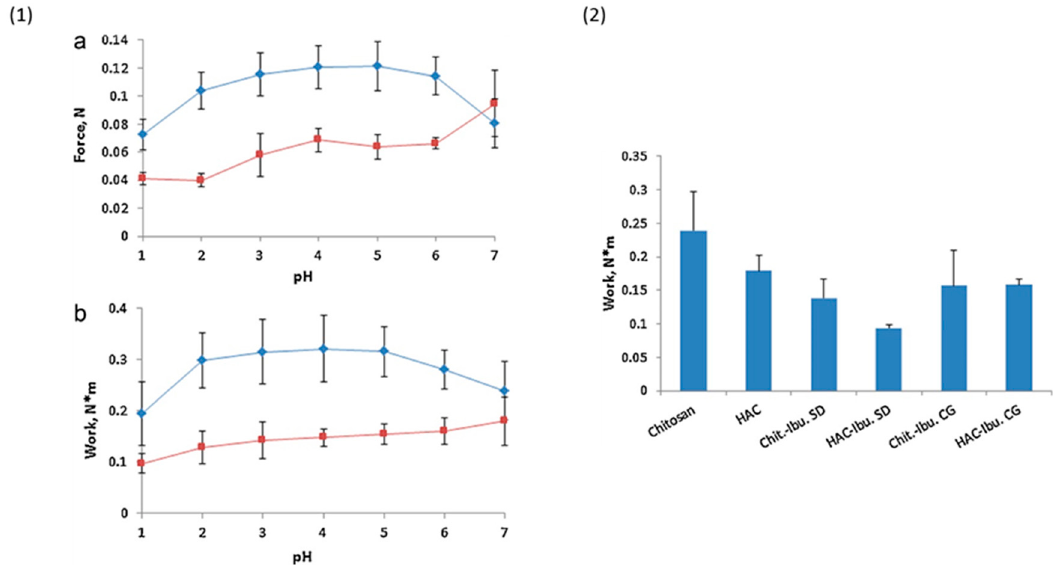
Figure 12. ( 1 ) Detachment force ( a ) and work of adhesion ( b ) for chitosan ( (cid:7) ) and half-acetylated chitosan (HACHI) ( (cid:4) ) tablets as a function of pH on porcine gastric mucosal tissues at 37 ± 0.1 ◦ C. Mean ± SD, n = 3. ( 2 ) Work of adhesion of tablets on porcine gastric mucosa at pH 7.0 and 37 ± 0.1 ◦ C. Chit.: chitosan, Ibu.: ibuprofen, SD: spray-dried, CG: co-ground. Mean ± SD, n = 3. Reprinted from [35] with permission of Elsevier.